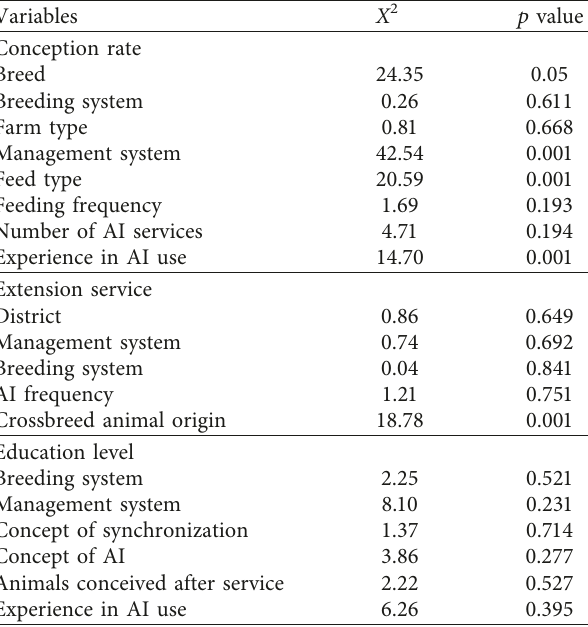
Table 6: Association of conception rate, extension service, and education level with different factors in the study